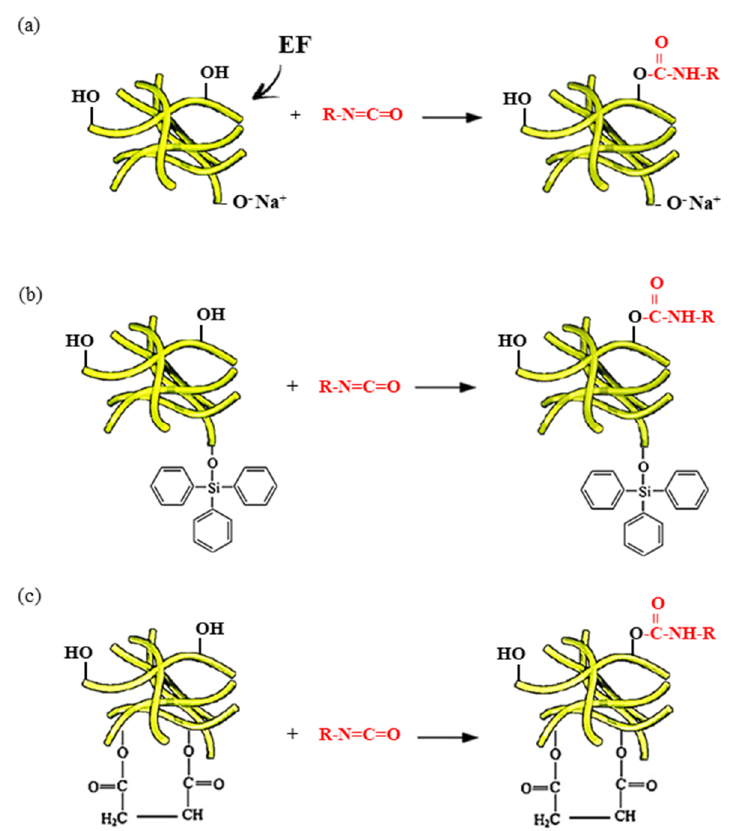
Figure 9. The possible mechanism between ( a ) alkali-treated, ( b ) silane-treated, ( c ) maleic-treated eucalyptus fibers and isocyanate groups.